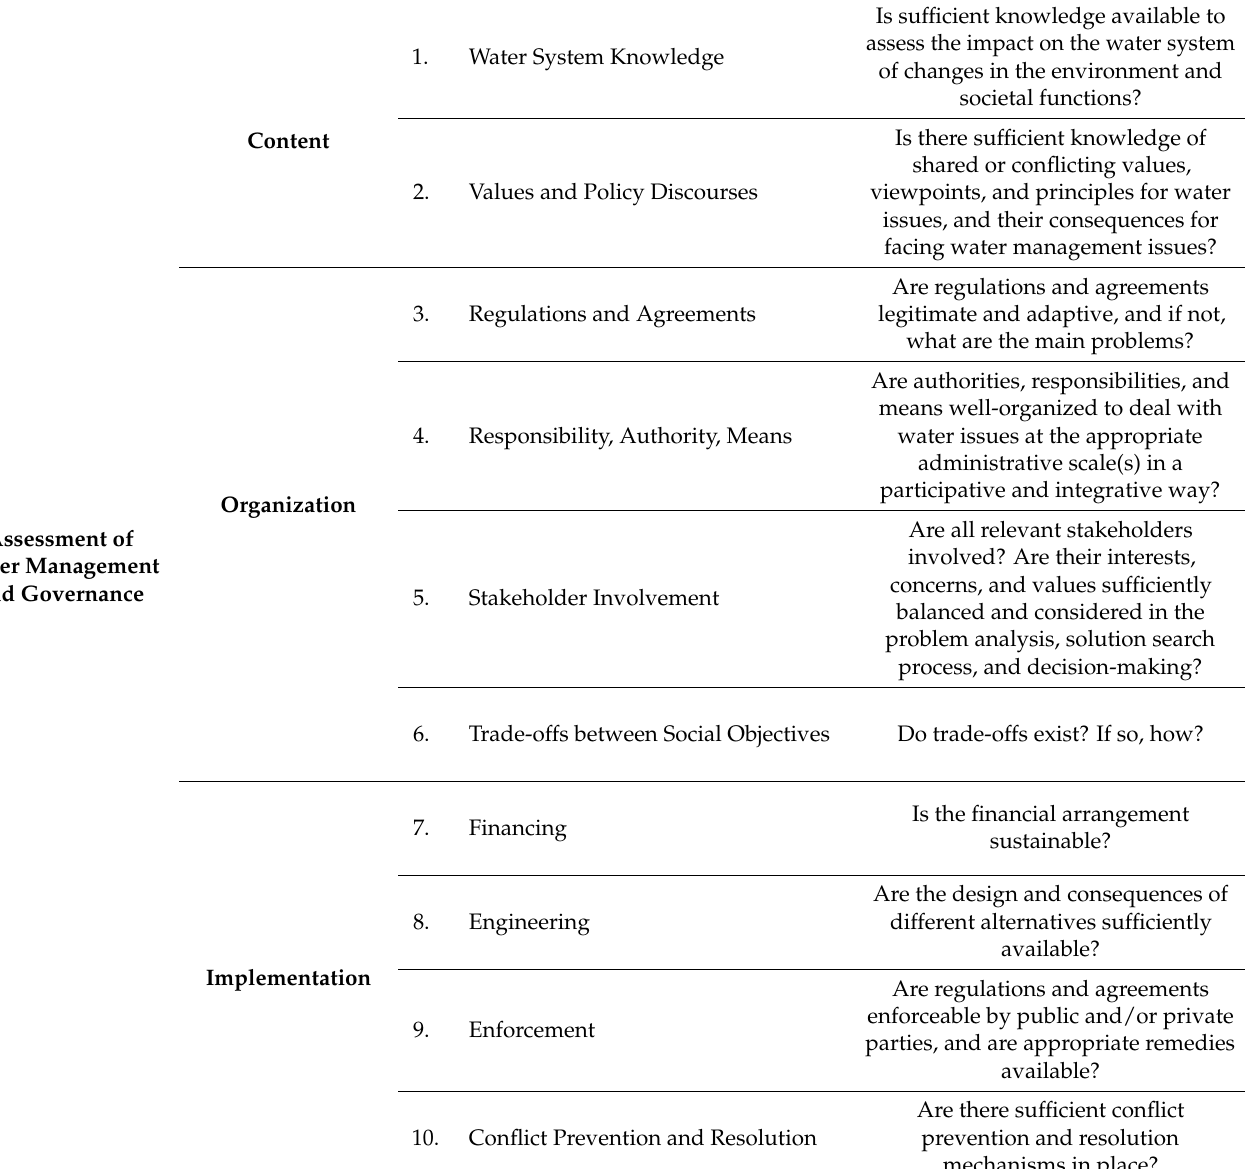
Table 1. Ten Building Blocks for Assessing Integrated Water Governance